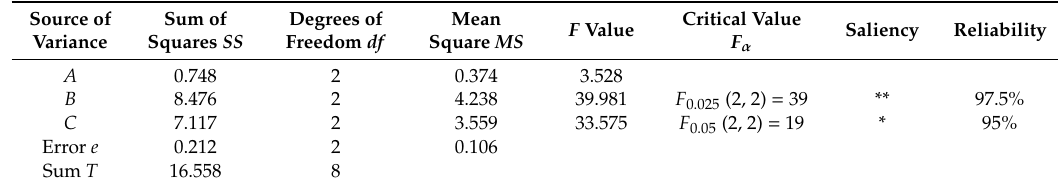
Table 7. Analysis results of deformation variance of thin-walled